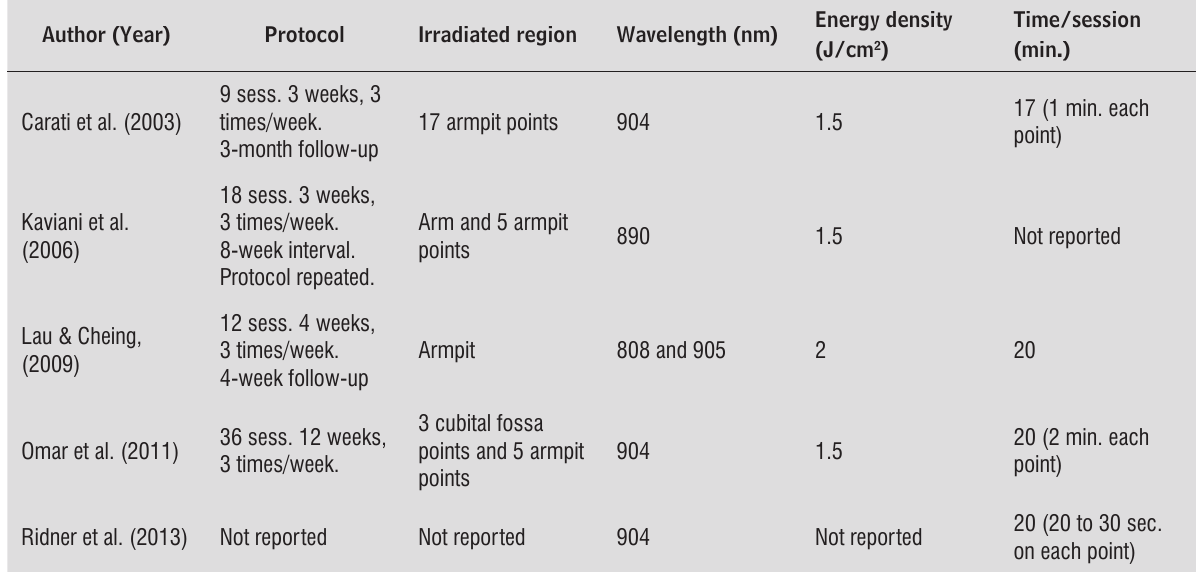
Table 4 - Literature search protocol in Pubmed, PEDro and Lilacs